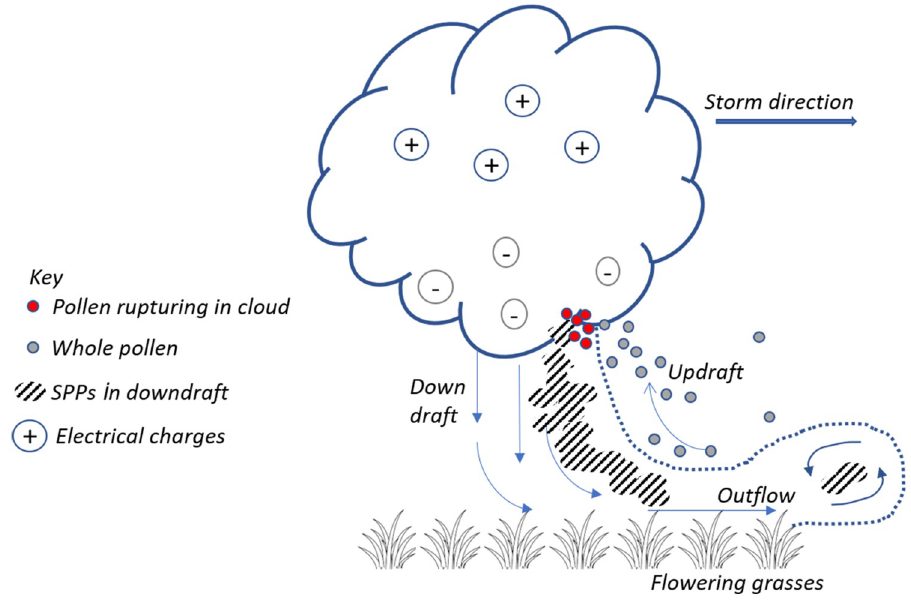
Fig 1. Schematic of hypothesised pollen entrainment into a thunder cloud, rupturing and deposition mechanisms/processes. After Taylor and Jonsson [13].